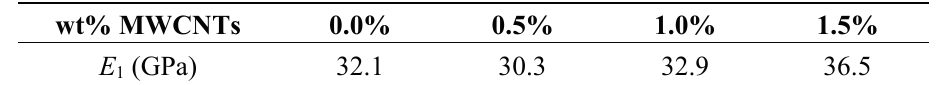
Table 1. Elastic modulus of the carbon fiber reinforced polymer (CFRP) composite